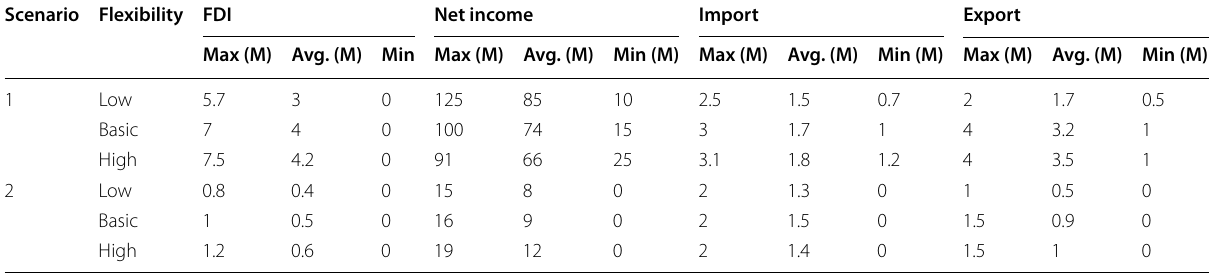
Table 3 Simulation results of different flexibility of supply chain based on the 95% confidence interval Scenario Flexibility